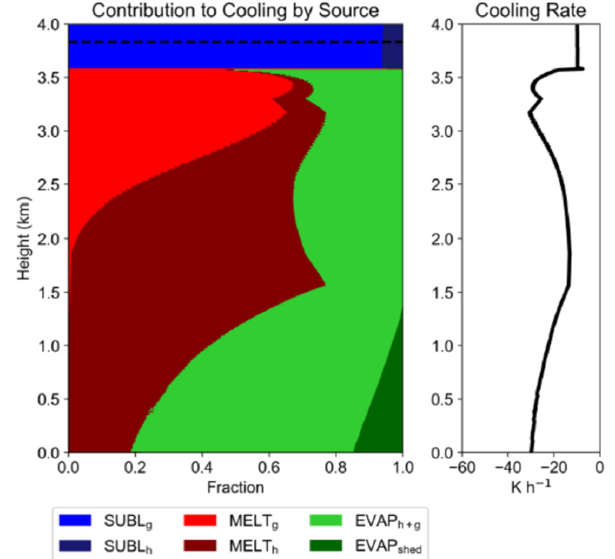
Figure 20. ( Left panel ) Relative contributions to the cooling rate by di ff erent microphysical processes: sublimation of graupel (SUBL g ), sublimation of hail (SUBL h ), melting of graupel (MELT g ), melting of hail (MELT h ), evaporation of rain resulting from melted graupel and hail (EVAP h + g ), and evaporation of raindrops shed from melting hailstones (EVAP shed ) as functions of height below the freezing level. ( Right panel ) Vertical profile of cooling rates resulting from all diabatic processes. More details of the model can be found in the literature [22]. Atmosphere 2020 , 11 , x FOR PEER REVIEW